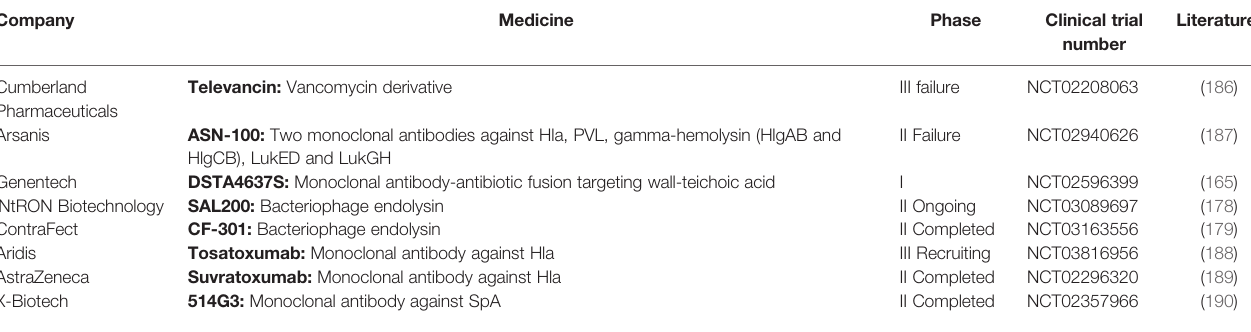
TABLE 2 | Therapeutic treatments for Staphylococcus aureus infections currently enrolled in clinical